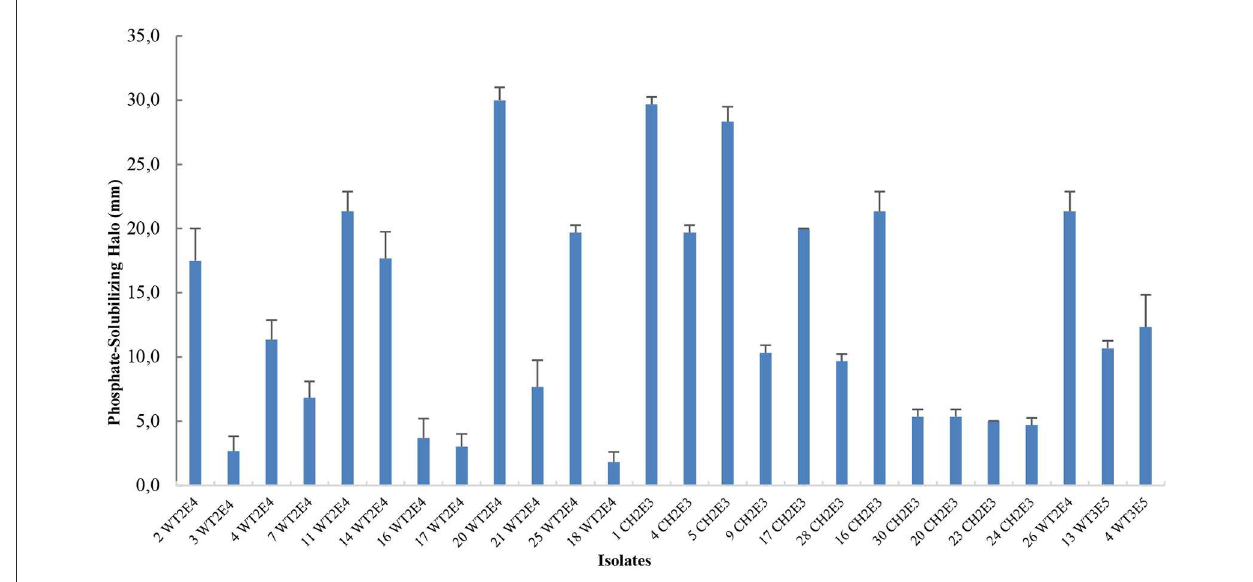
FIGURE1 Qualitative test of P solubilization on Pikovskaya (PVK) medium